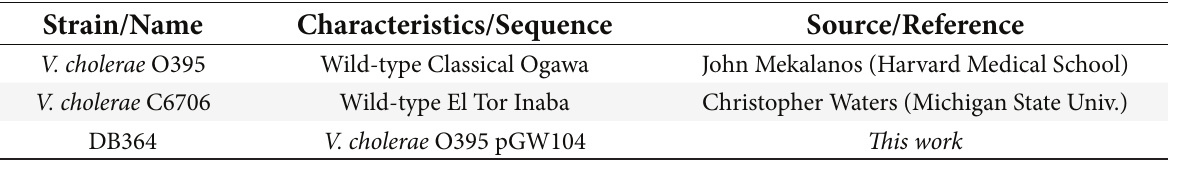
Supplementary Table 1 . List of bacterial strains utilized in this work.